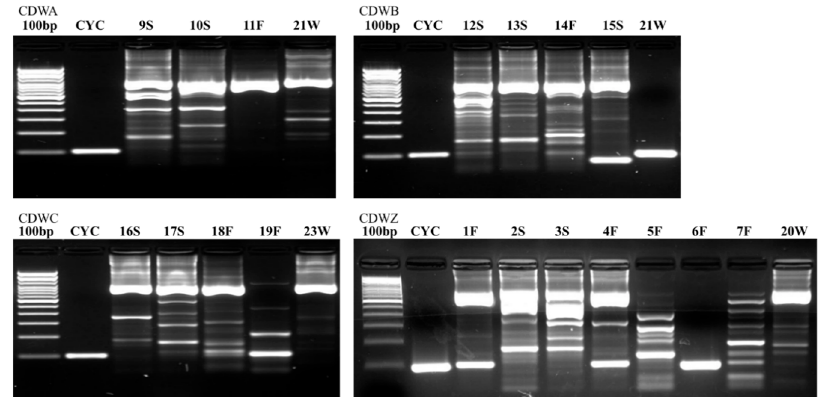
Figure 2. C. cayetanensis DNA amplification from environmental and wildlife fecal samples collected from Caldwell Woods (CDW). The transect the samples were collected from is denoted as A–C and Z followed by the sample number and type (F = feces, S = soil, and W = water). The DNA was amplified using two rounds of PCR. The 100 bp standard (located in lane 1, far left, in each image) was used to assess the amplicon size. The Cyclospora (CYC) DNA (located in lane 2 of all gels) represents the correct positive band position at 100 bp. Positive samples were identified by a positive band at 100 bp.